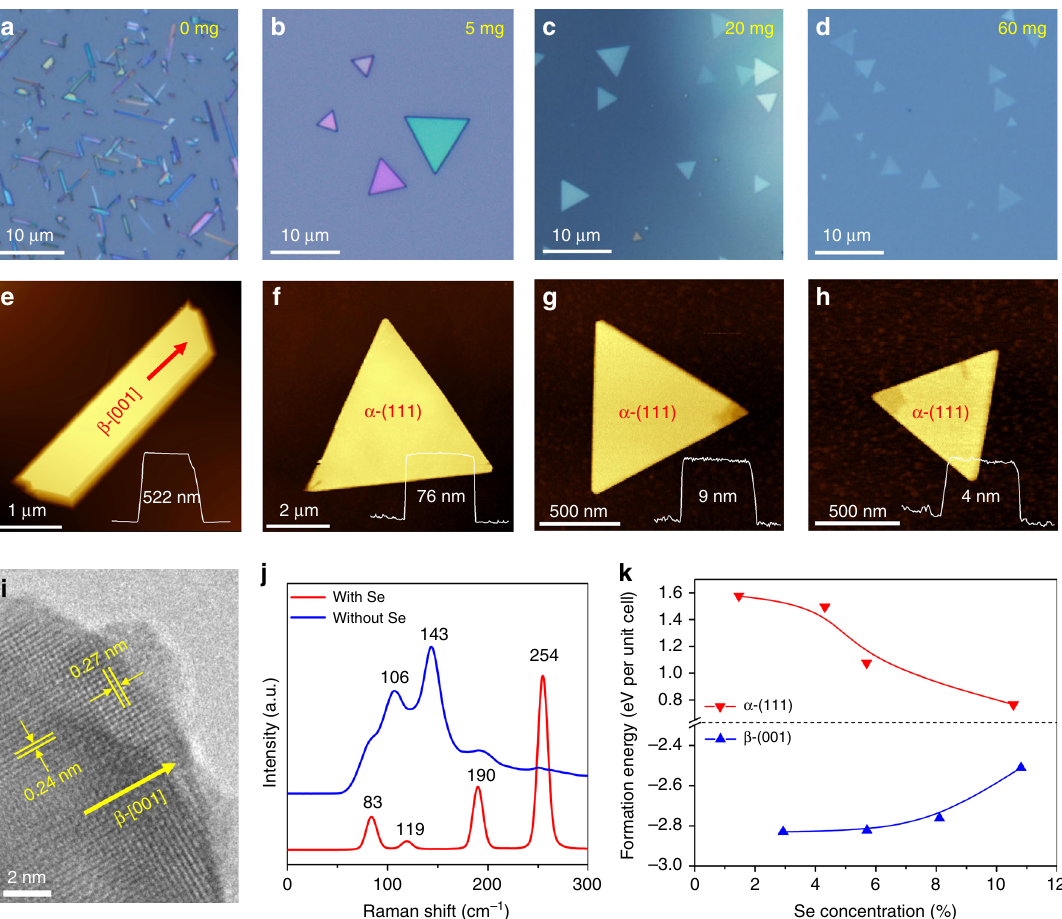
Fig. 3 Morphology and phase evolution of Sb 2 O 3 with the amount of Se passivator. a − h Typical optical and corresponding AFM images: a , e 0 mg; b , f 5 mg; c , g 20 mg; d , h 60 mg. The morphology of Sb 2 O 3 is changed as follows: submicronwires → thick fl akes → thin fl akes → ultrathin fl akes. Phase is changed from β (orthorhombic phase) ( a ) to α (cubic phase) ( b − d ). i TEM image of the β -phase Sb 2 O 3 submicronwire in ( a ) without Se (0 mg); j Typical Raman spectra of the submicronwires and fl akes. k DFT-calculated formation energy of β -(001) plane and α -(111) plane with different concentration of Se passivators, indicating the opposite role played by Se. This relation reveals that the growth of α / β phase is promoted/suppressed with the increase of